Question: In a single sentence, describe what this figure presents.
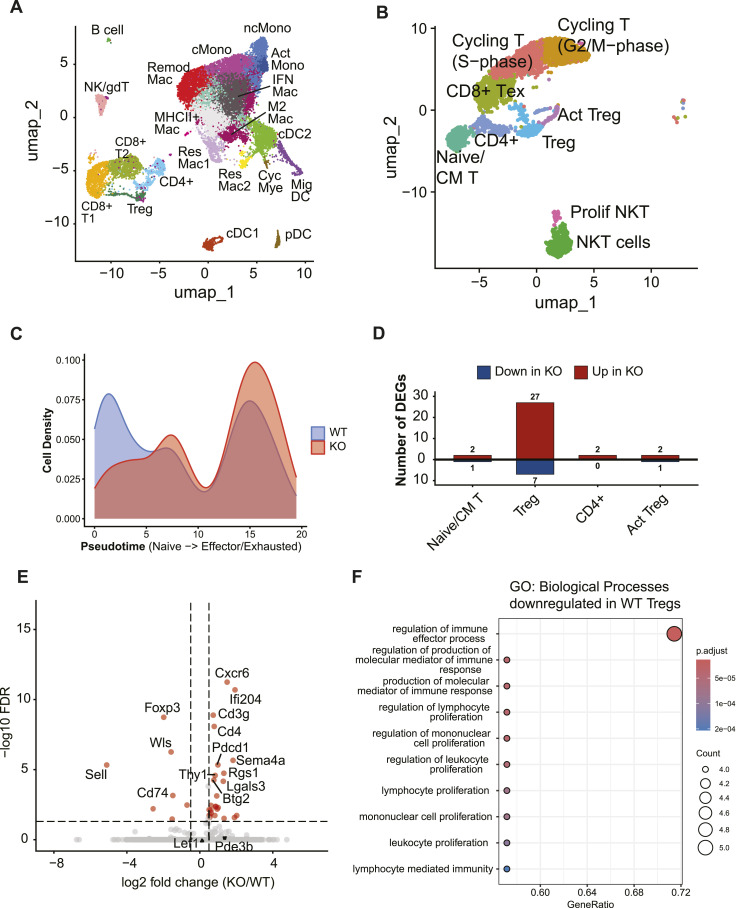
Answer: SATB1 is necessary for proper function of Treg under tumor burden. (A) UMAP visualization of scRNA-seq data integrating 20 distinct immune cell clusters from CD45 + TILs isolated from B16-F10 tumor–bearing WT and Satb1 cKO mice. (B) Isolated re-clustering of T-cell populations, identifying nine distinct T-cell subpopulations. (C) Pseudotime trajectory analysis mapping the progression of intratumoral T cells from naïve to effector/exhausted states. (D) Bar graph quantifying the total number of up- and down-regulated differentially expressed genes across different T-cell subclusters in the absence of SATB1. (E) Volcano plot detailing the transcriptomic alterations specifically within the intratumoral Treg subpopulation, highlighting reduced Foxp3 and increased Pdcd1 . (F) Gene Ontology biological pathways significantly down-regulated in SATB1-deficient Tregs, emphasizing a reduction in immune effector regulatory processes.